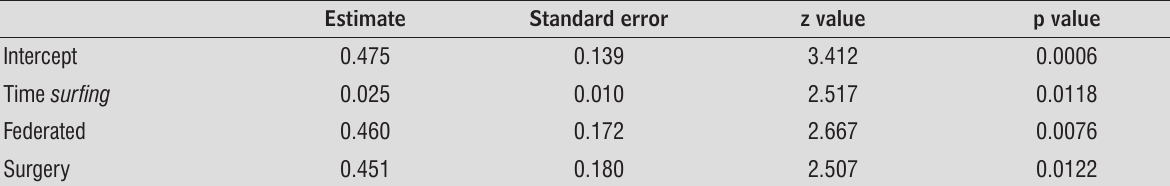
Table 5 - Log-linear Poisson Model